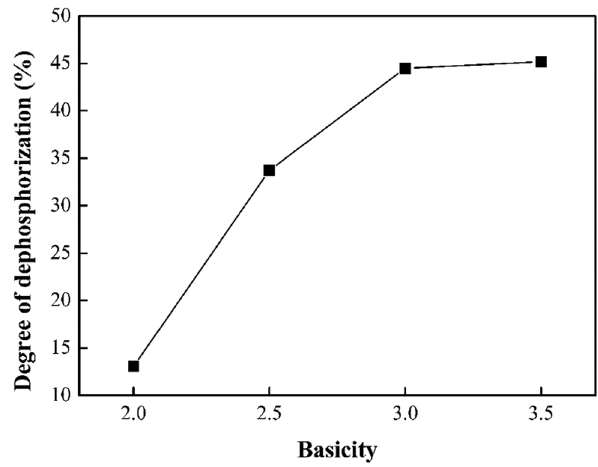
Figure 3: Relationship between dephosphorization e ffi ciency and